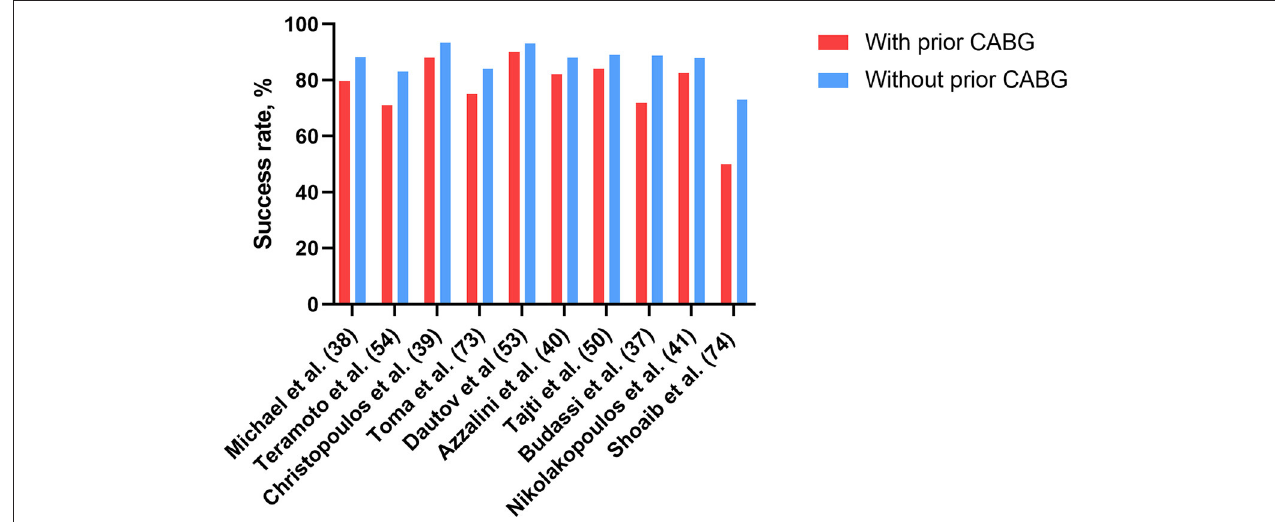
FIGURE 1 | Successful rates of CTO-PCI in patients with and without prior CABG in recent studies. CABG, coronary artery bypass grafting; CTO, chronic total occlusion; PCI, percutaneous coronary